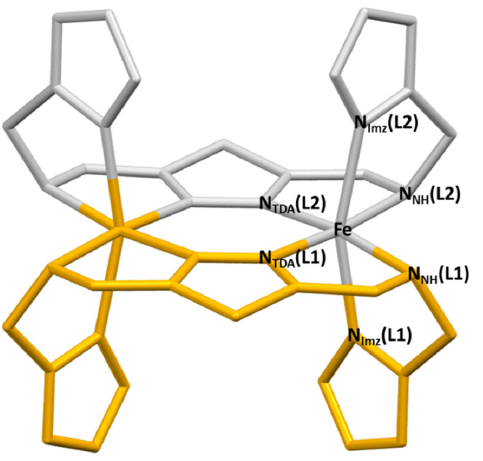
Figure 2. Sketch of the centrosymmetric complex cation [Fe II2 ( I 4 MTD ) 2 ] 4+ , showing the cis - coordination of the ligand as well as octahedral coordination environment for the iron(II) ions. Table 1. Selected bond lengths (Å), N-Fe-N bond angles ( ◦ ) and the octahedral distortion parameter [ ◦ ] for the compounds C1 – C3 . For compound C3 the values are given for di ff erent temperatures.